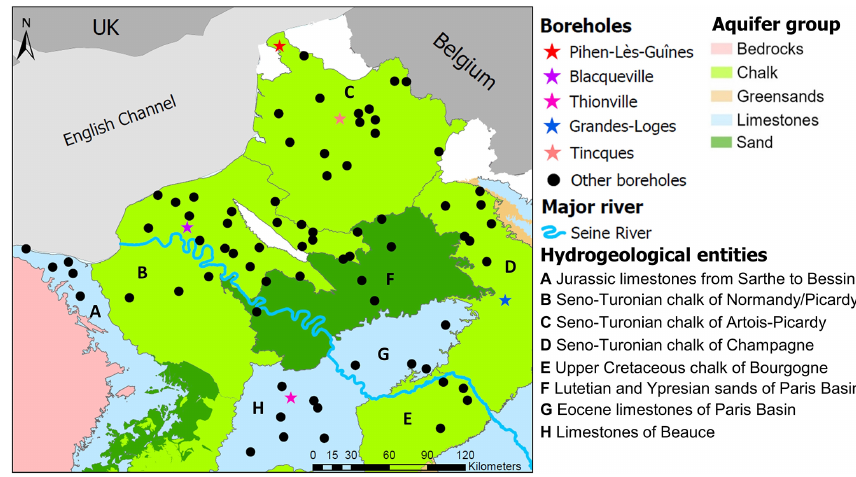
Figure 1. Spatial distribution of the 78 selected boreholes through major hydrogeological entities of the Paris